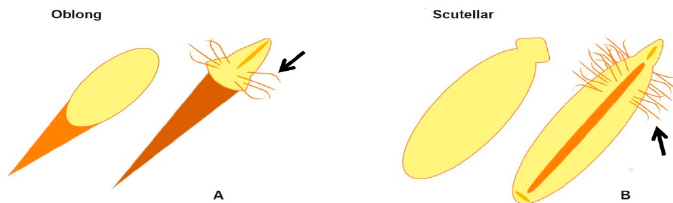
Figure 1. Schematic surface morphology of somatic embryos of T. domingensis in the oblong ( A ) and scutellar ( B ) stages, and nontransformed (left) and agrotransformed (right) stages. Both arrows shown the induction of hairy roots. For a complete histogenic model of the somatic embryos of T. domingensis, please refer to Hern á ndez Piedra et al. [33].